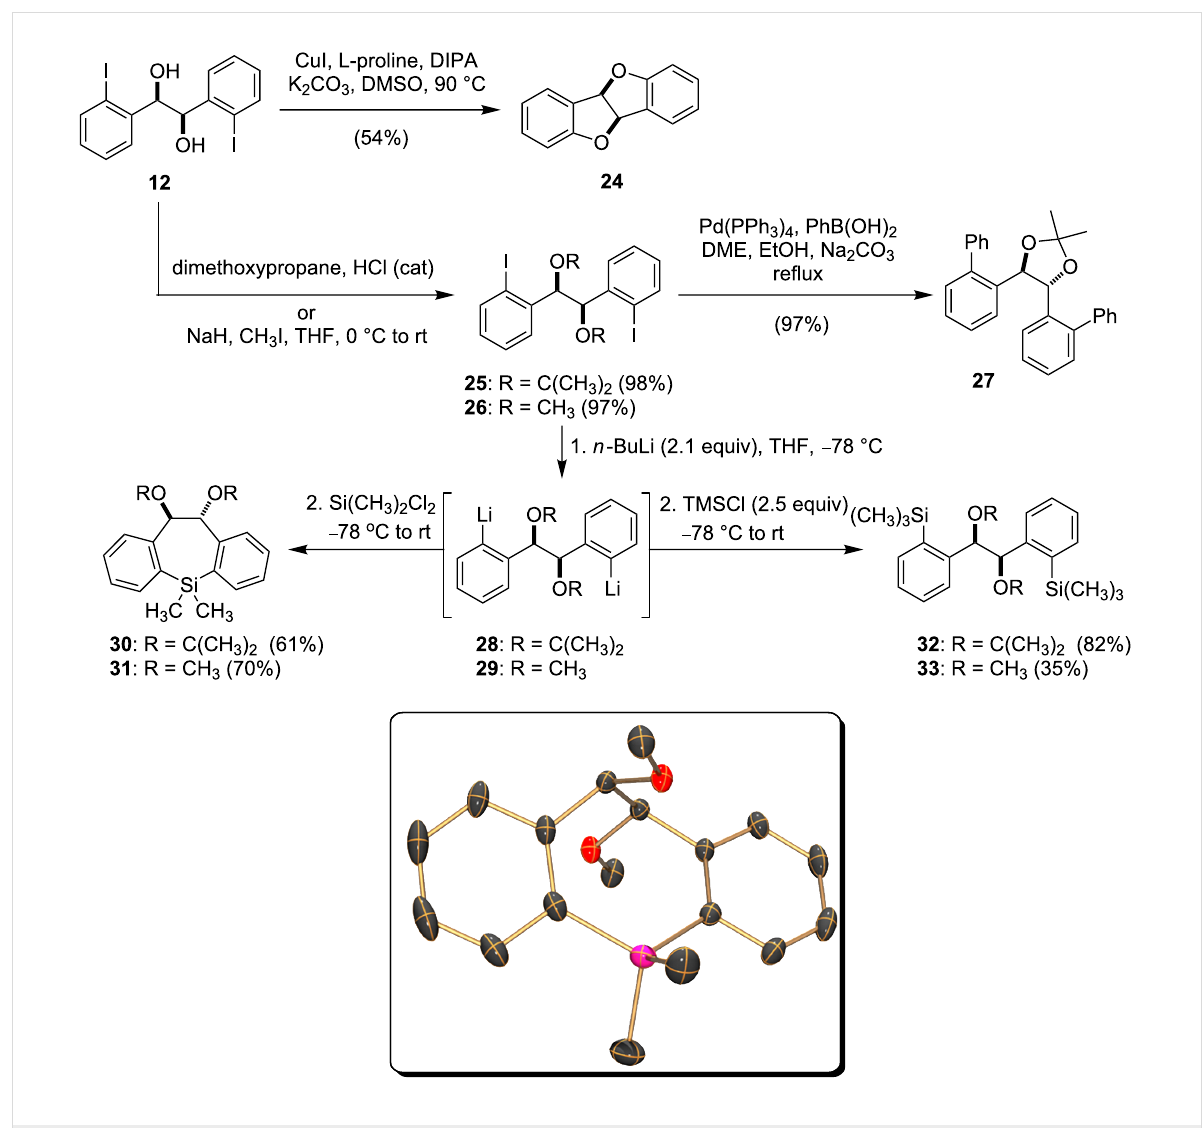
Scheme 4: Reactions of the diiodohydrobenzoin 12 and X-ray crystal structure of the dihydrosilepin 31